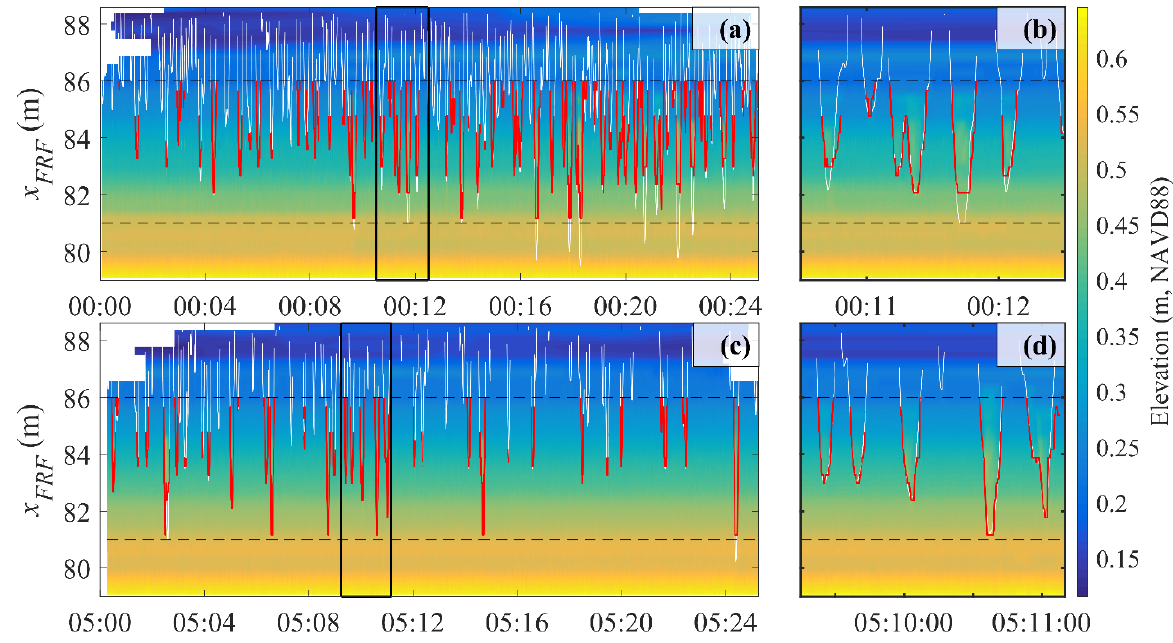
Figure 10. Cross-shore wave runup excursion, R x , measured by the LLC LiDAR (red) and the FRF DUNE LiDAR (white) for two 25-min spans during Series C (18 November 2020): ( a , b ) rising tide, and ( c , d ) falling tide. The dashed black lines mark bounds of the optimal cross-shore zone for runup detection, beyond which, LLC LiDAR wave runup estimates were unreliable. The colored surface is the LLC LiDAR-derived surface elevation, S . The thick black boxes in ( a , c ) define the time spans expanded in ( b , d ). Times in UTC.